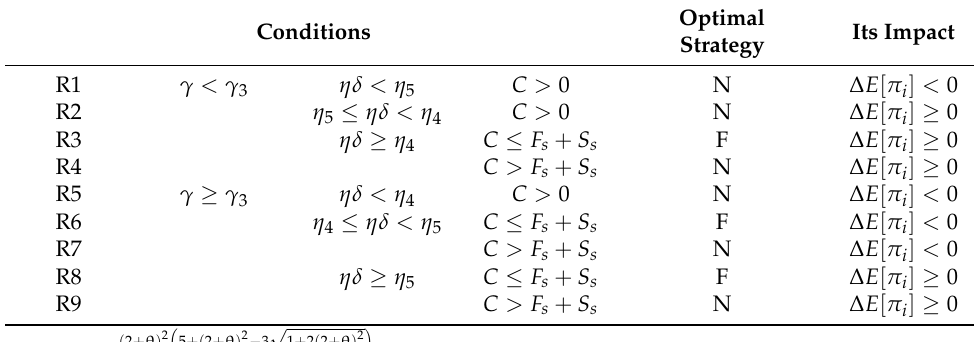
Table 2. The impact of the optimal strategy on the e-tailers.